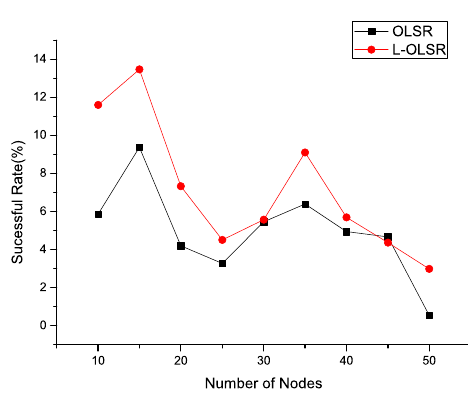
Fig.9. Delivery success rate (DSSS 1M).